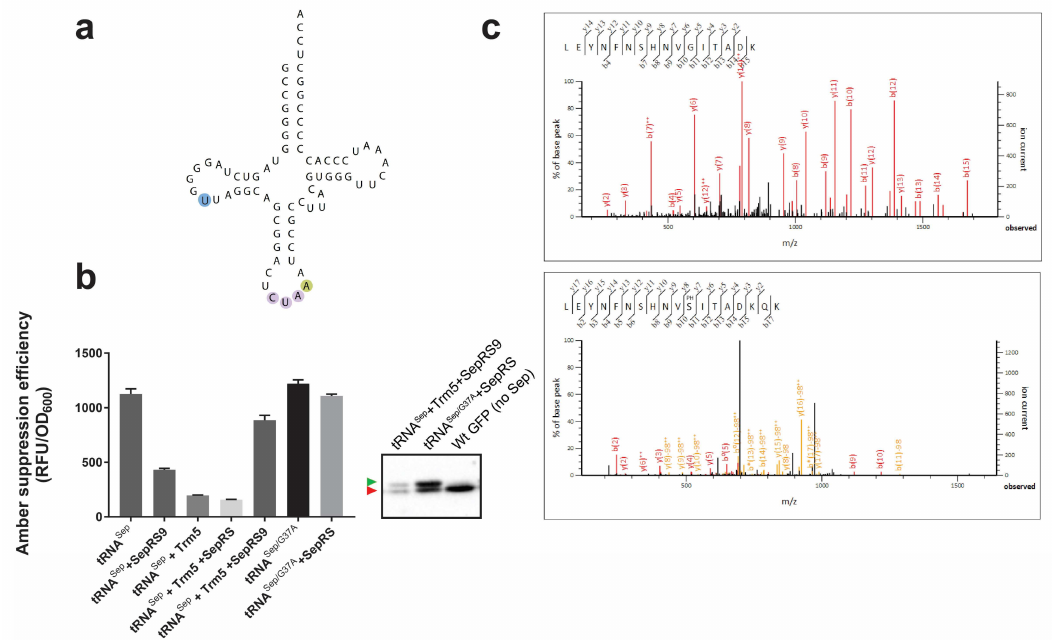
Figure 2. ( a ) Secondary structure of tRNA Sep/G37A . Anticodon bases are highlighted and the G37A mutation is indicated. ( b ) The effect of M. maripaludis Trm5 on the stop codon read-through with original tRNA Sep and tRNA Sep/G37A in the presence or absence of wild-type SepRS or SepRS9 variant. sfGFP-2TAG expression was monitored by fluorescence in a BL21(DE3) strain grown in Luria-Bertani (LB) medium supplemented with 5 mM Sep. Responses were taken at 20 h. The amber suppression efficiency is measured relative to the cell density (OD 600 ). Phos-tag TM mobility shift analysis of GFP-2TAG isolated from the strains harboring tRNA Sep , SepRS9, and Trm5 and tRNA Sep/G37A variant and wild-type SepRS. OTS components are indicated above the wells. Proteins were detected by Western blot using anti-GFP antibodies. The green arrow indicates the position of the Sep-containing GFP, while the red one points to the position of cAA-containing GFP. ( c ) Endogenous GlyRS likely charges MjtRNA Sep with Gly. LC-MS/MS analyses of sfGFP-151TAG demonstrate that in the presence of Sep-OTS (tRNA Sep CUAG37A system), both Sep and Gly incorporation occur. The tandem mass spectrum of the peptides (residues 141–156) LEYNFNSHNVGITADK (ion score 116.5) and LEYNFNSHNVSepITADK (ion score 52.9) from purified sfGFP with one amber codon at position 151 from E. coli BL21 (DE3), using the tRNA Sep CUA G37A -containing Sep-OTS. Cells were grown without additional Sep in the